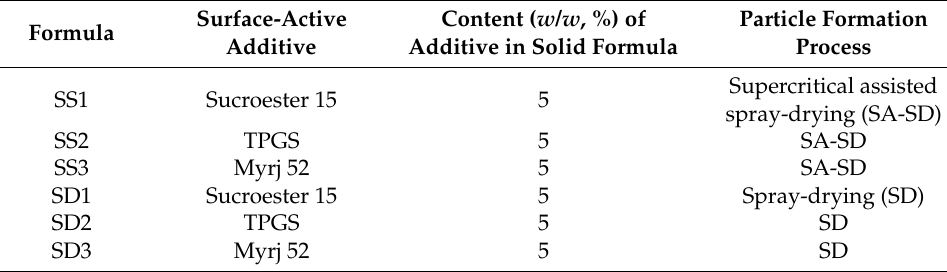
Table 1. The formulations of the fenofibrate microparticles with surface-active additives. Surface-Active Formula